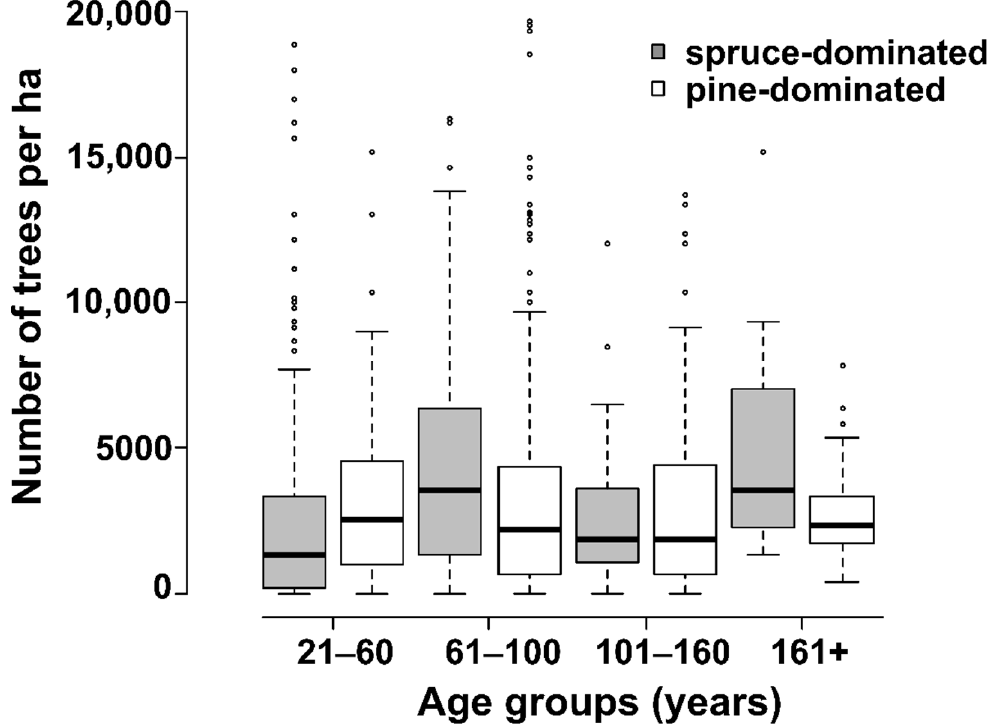
Figure 2. The density of advance regeneration in Norway spruce- and Scots pine-dominated stands in